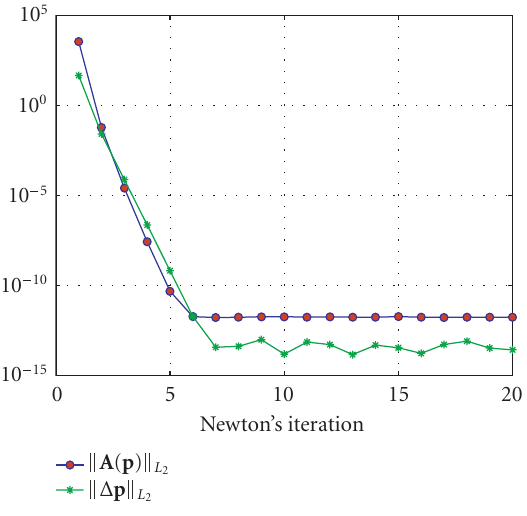
Figure 4.12 . Example 4.3: residual and di ff erence vector versus Newton’s iteration.